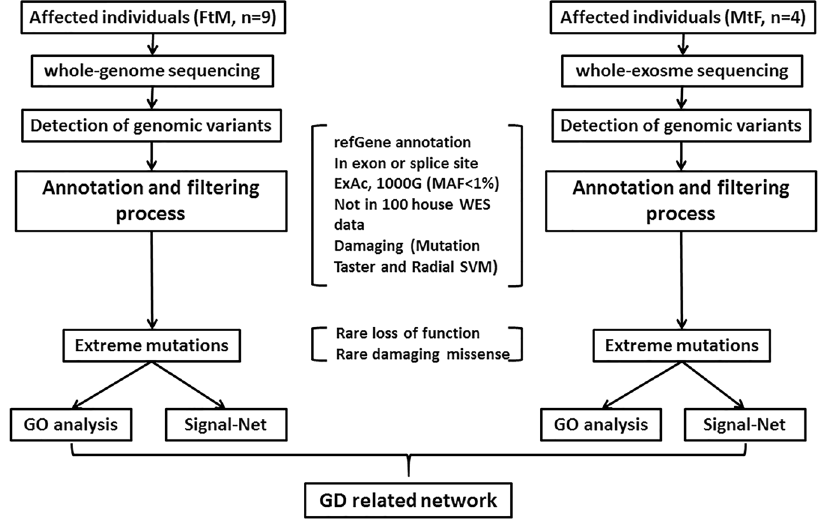
Figure 1. Flowchart for the exploration of disease genes in sporadic GD